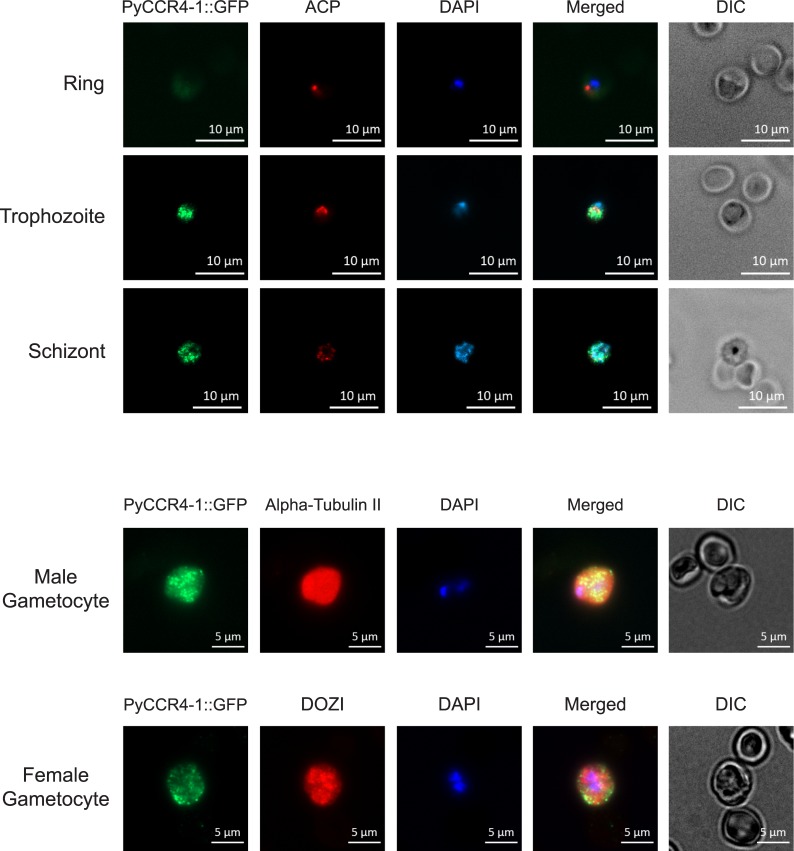
PyCCR4-1::GFP is expressed in cytosolic granules in asexual and sexual blood stage parasites.Representative images of parasites treated with DAPI and antibodies to GFP (to detect PyCCR4-1::GFP) or to stage-specific cellular markers (ACP, alpha-tubulin, or human DDX6 that cross-reacts with DOZI) are shown. Scale bars are 5 or 10 microns.